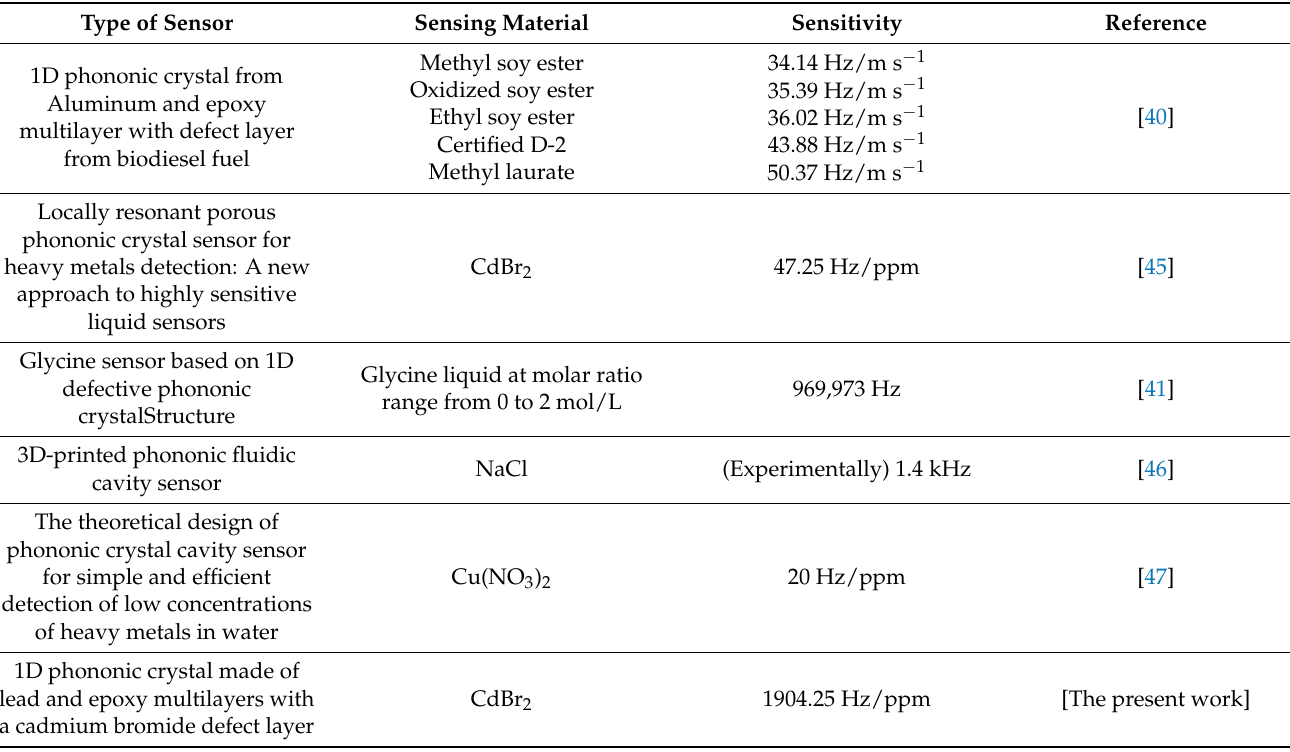
Table 2. Comparison of the sensitivity of the proposed design with previously published